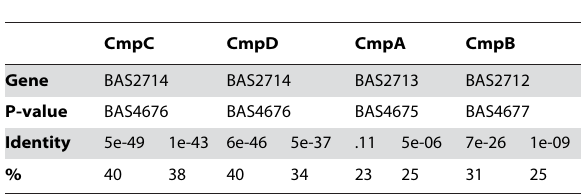
Table 1. Similarity analysis between the B. anthracis BAS2714-12 and BAS4675-77 transporter and the Synechococcus bicarbonate transporter CmpABCD.